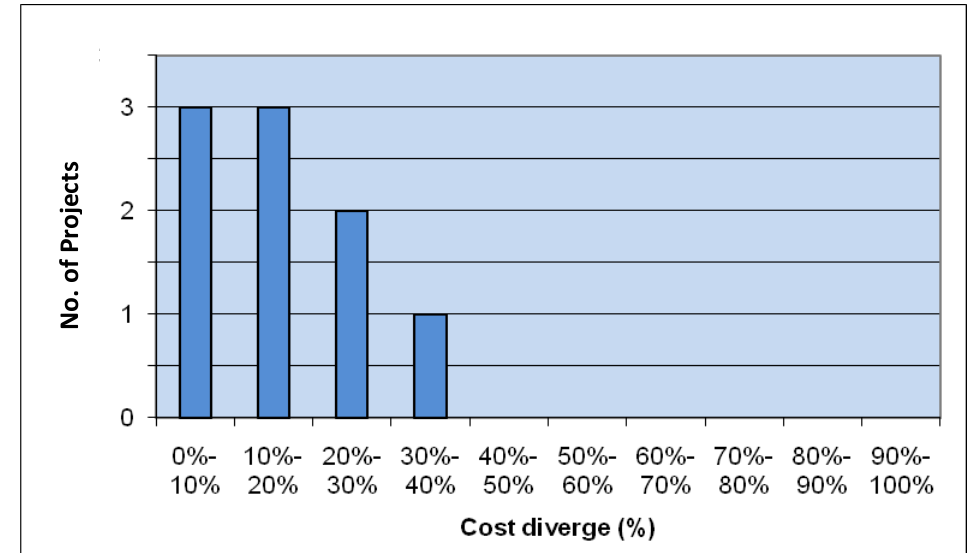
Figure 4 Cost over estimation vs. no of projects in very small road construction projects